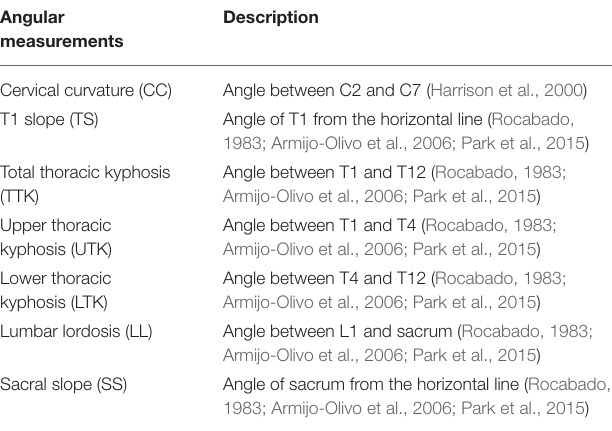
TABLE 2 | Angular measurements of spinal